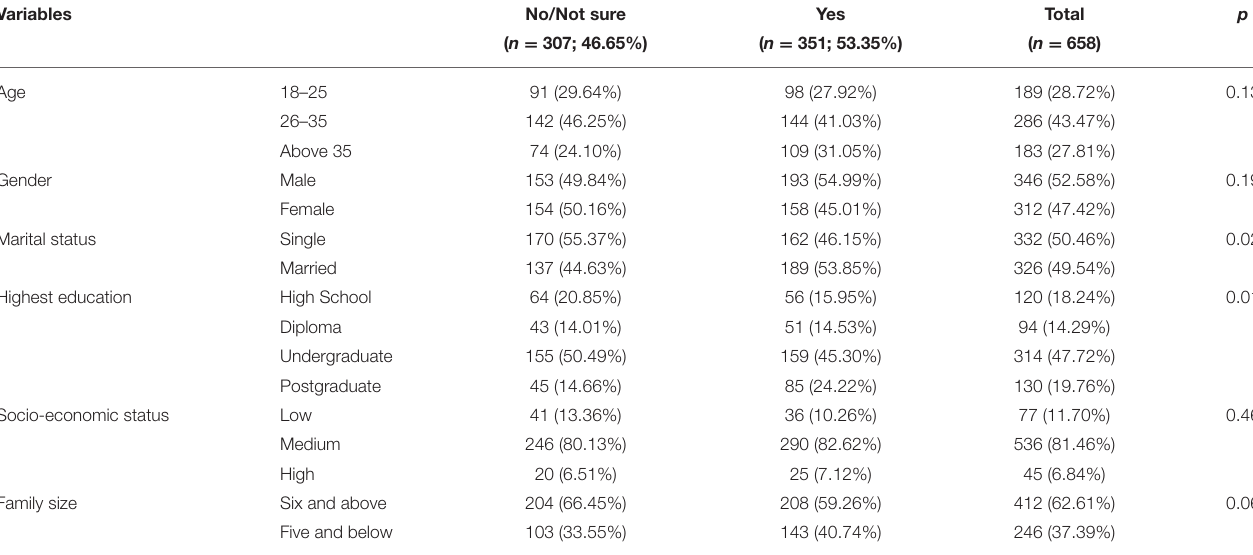
TABLE 3 | Bivariate analysis for association between demographics characteristics and intention to COVID-19 vaccination ( N = 658).